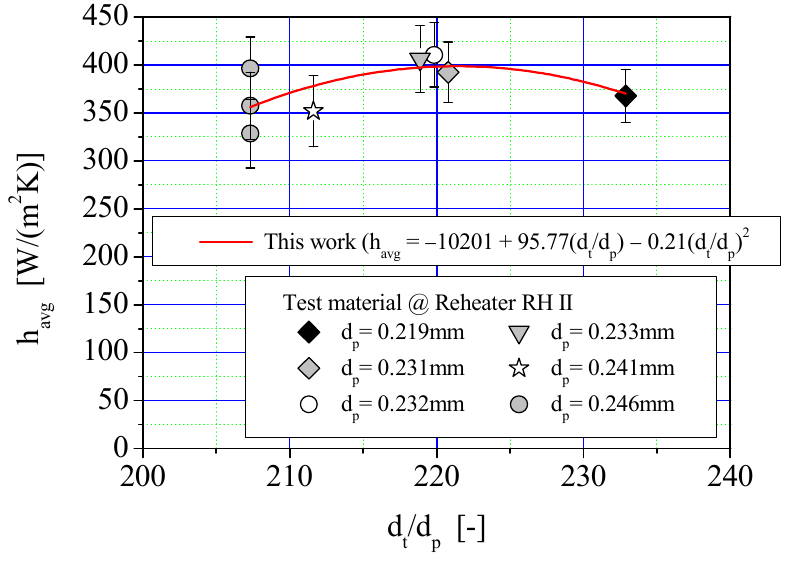
Figure 7. Average heat transfer coefficient versus Sauter mean particle diameter.